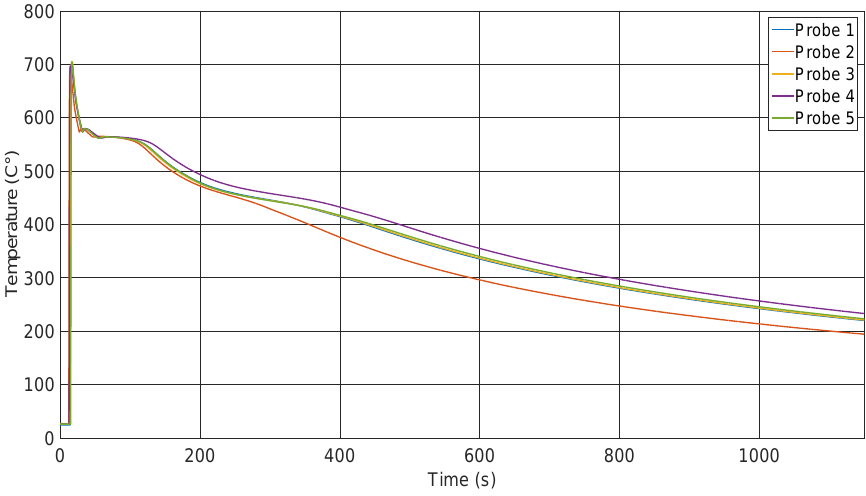
Figure 8. Temperature in the reference specimen.